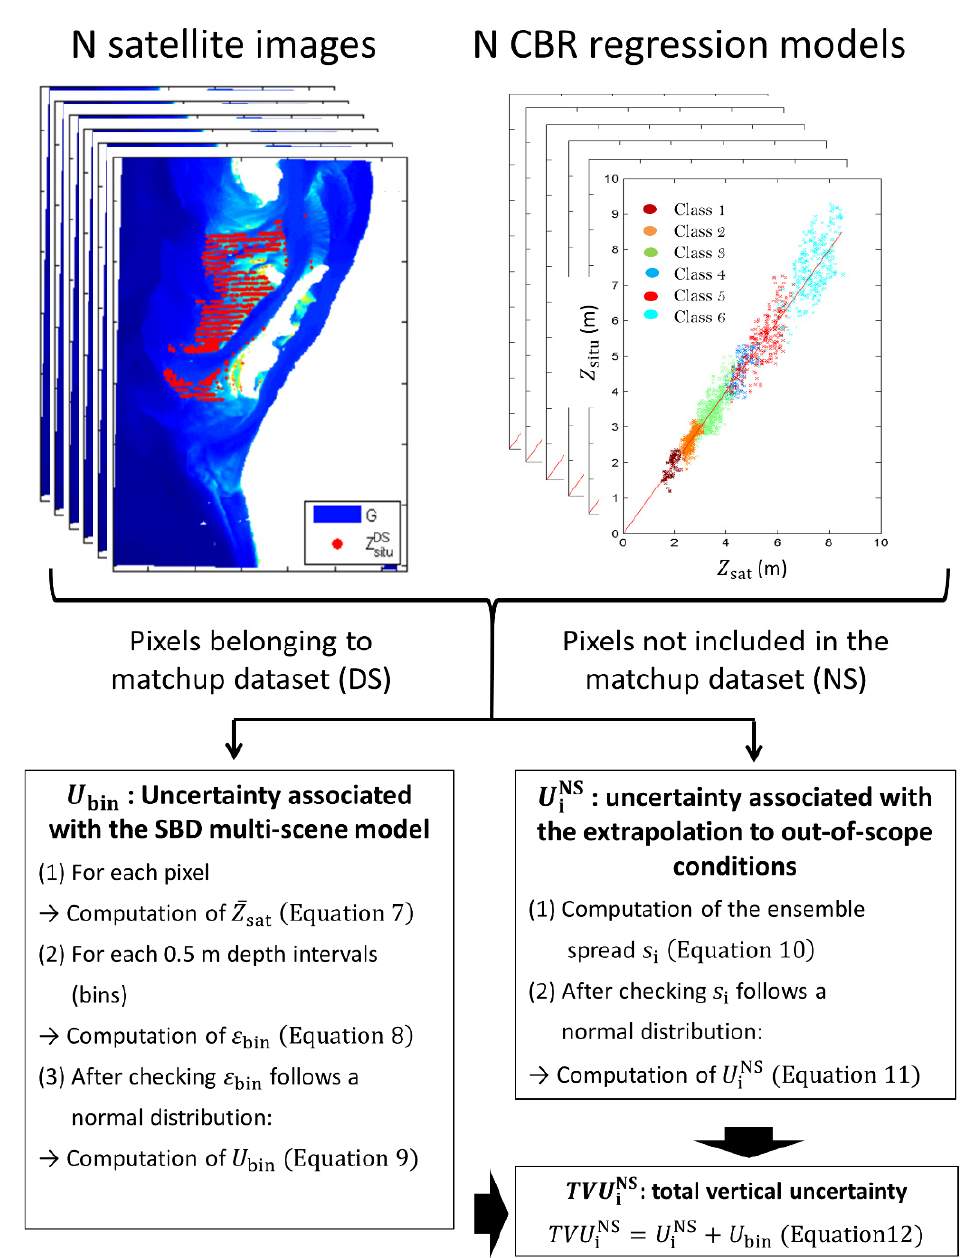
Figure 4. Flowchart describing the multi-scene algorithm used to quantify the 95% uncertainty on SDB.